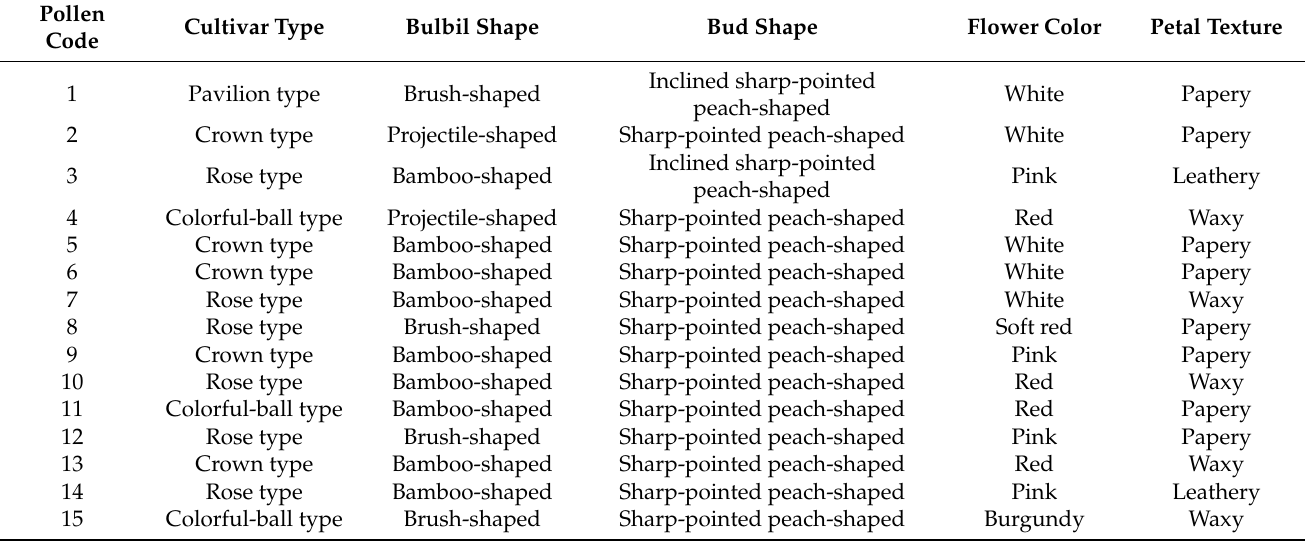
Table 1. Main morphological characteristics of the varieties of Paeonia lactiflora in the test.